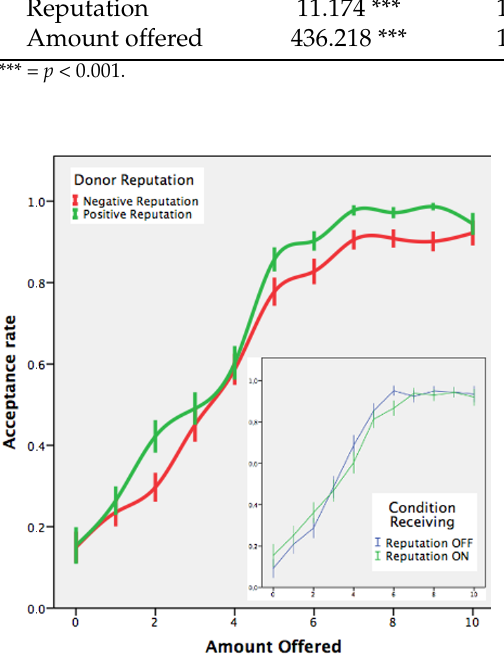
Figure 1. Acceptance dynamics with respect to positive and negative reputation of the interactor. In the insert, the acceptance rate trend related to the receiving conditions is